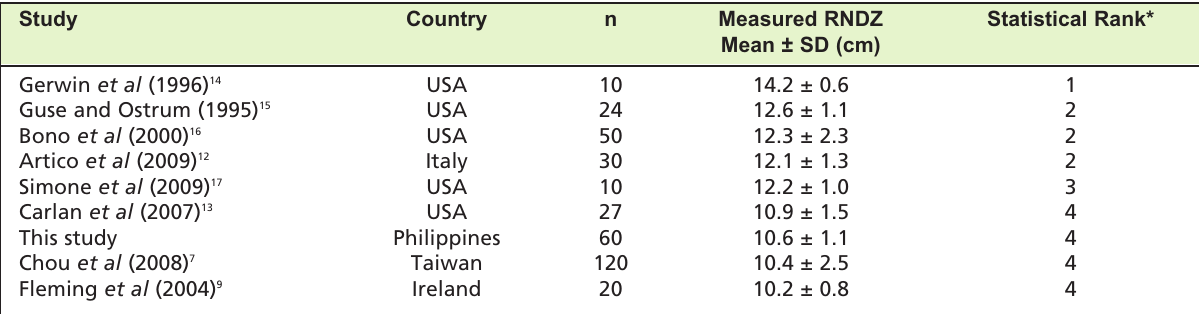
Estimates of the radial nerve danger zone, measured from the lateral epicondyle to the lateral intermuscular septum, Table IV: as reported in the literature